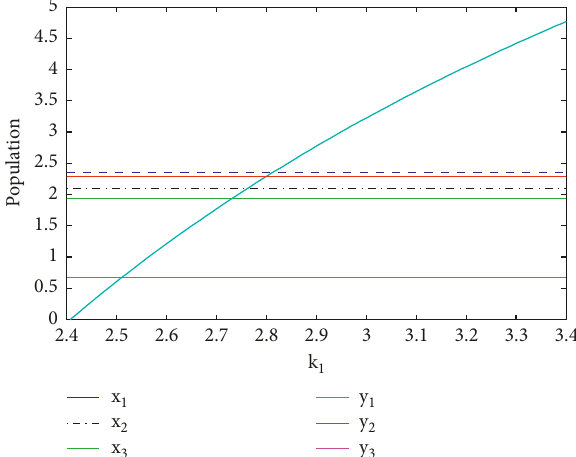
Figure 9: Effect of m